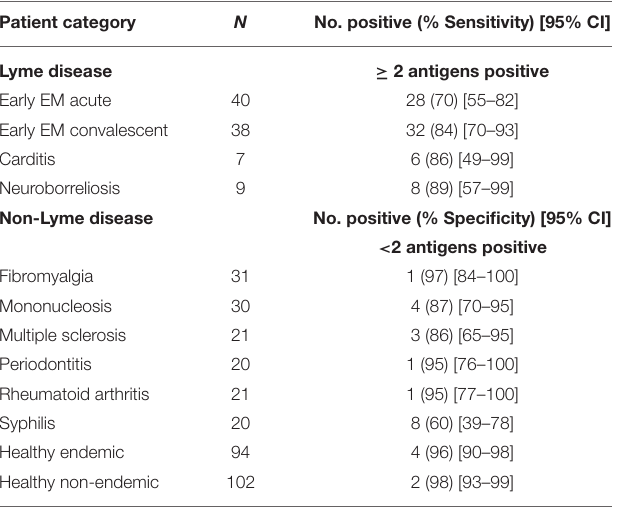
TABLE 1 | IgM plus IgG sensitivity and specificity of early Lyme disease patient samples. Patient